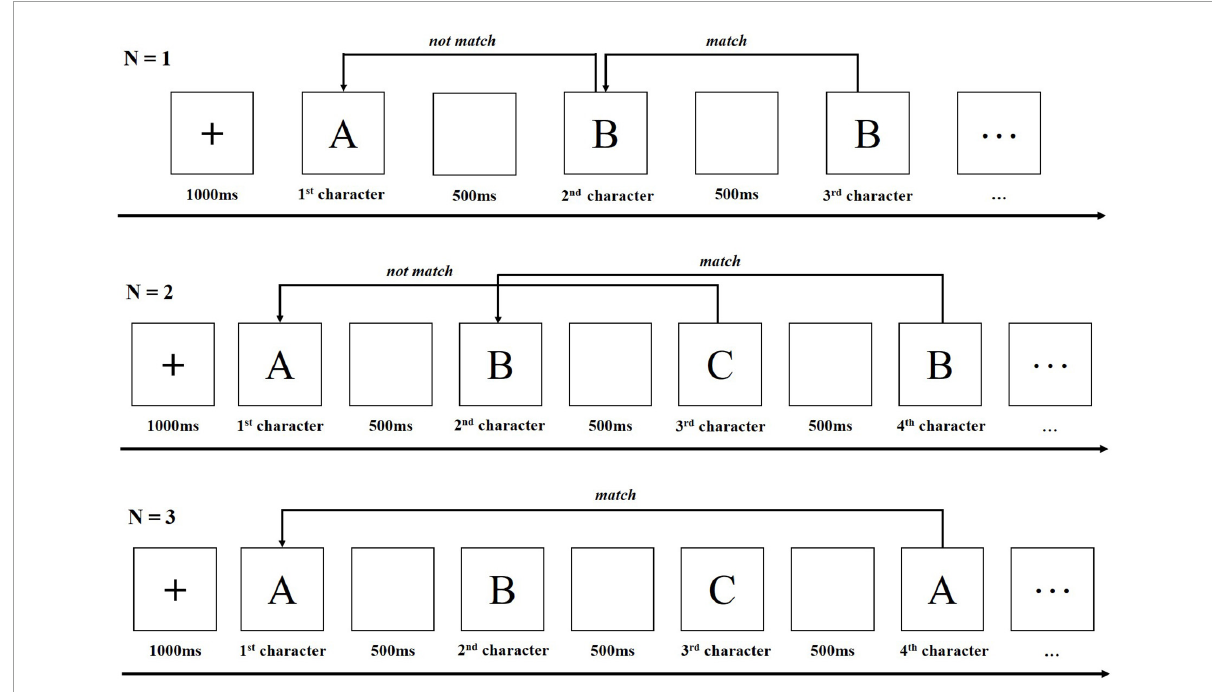
FIGURE1 Trial schematic of the n-back task